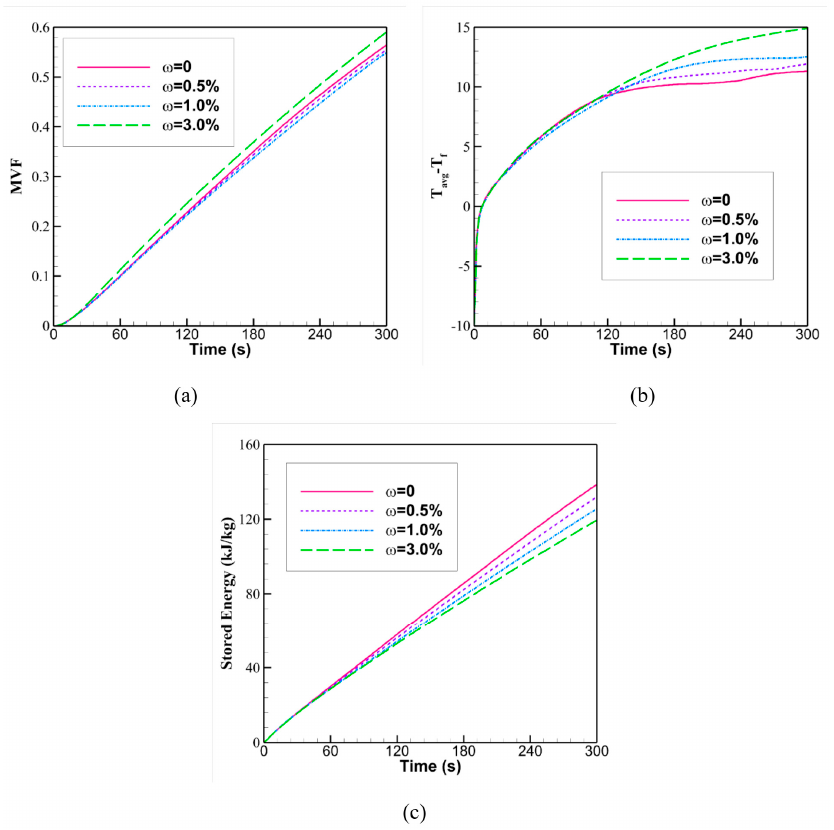
Figure 9. The ( a ) melting volume fraction, ( b ) surface heat transfer rate, and ( c ) stored energy as a function of time when ε = 0.95 and δ = 35.